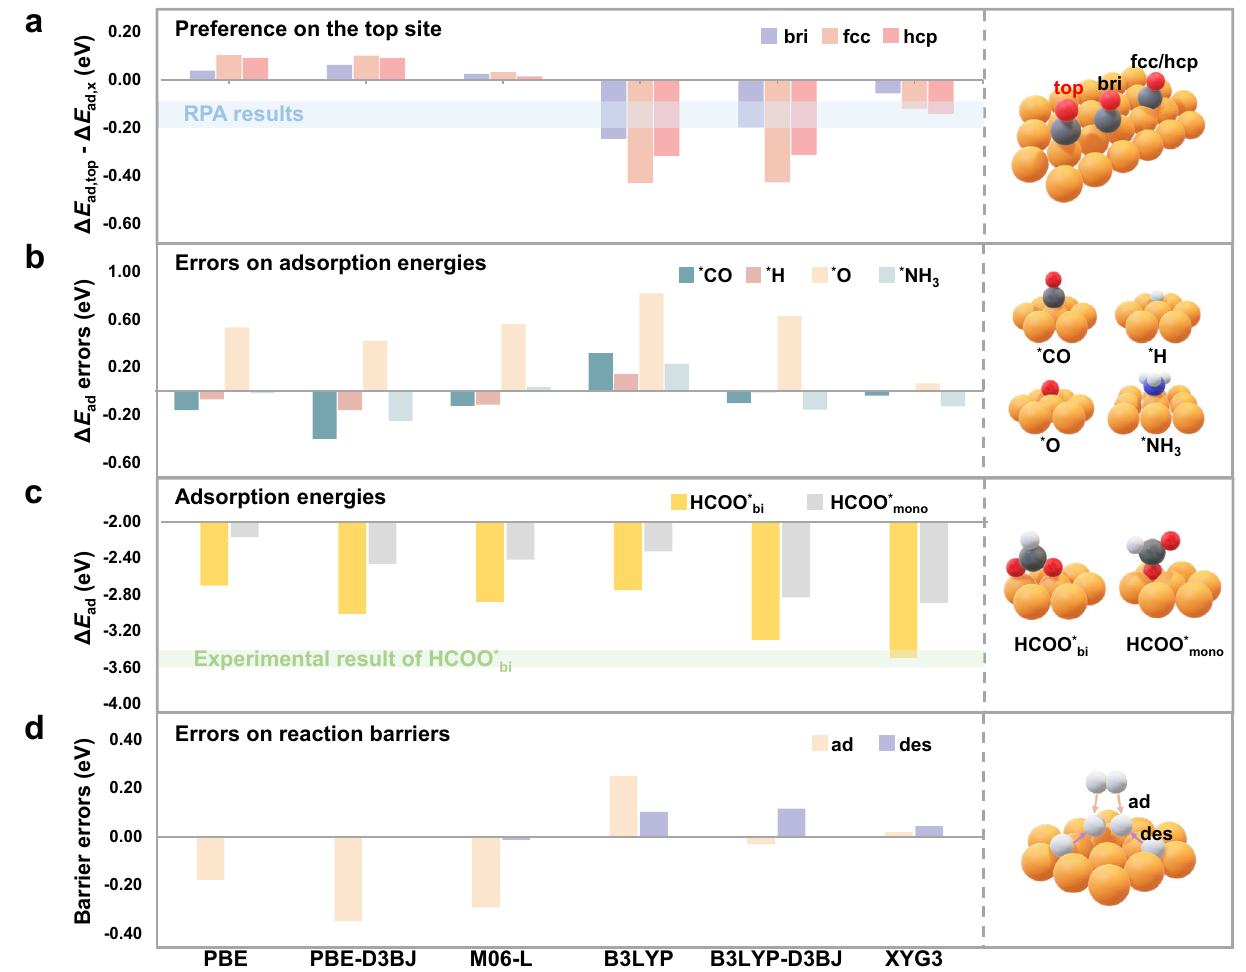
Fig.3|Thebenchmarkset.a PreferredCOadsorptionsiteontheCu(111)surface.A negative value suggests the top site be preferred in accordance with the experi- ment. The RPA results suggest a top site preference of 0.10eV 26 or 0.22eV 39 (the horizontalbarinlightblue),whichisusedasanindicatorfortheadsorptionenergy difference between the top and the hollow sites. b The computation errors for adsorptionenergiesofCO,H,andOontheCu(111)surface,andNH 3 ontheCu(100) surface. The experimental results are used as references. c The computed adsorption energies for bidentate (HCOO * bi ) and monodentate (HCOO * mono ) for- mateontheCu(111)surface.TheexperimentalresultofHCOO * bi ispresentedasthe